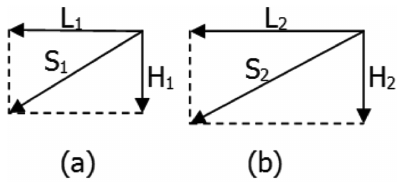
Figure 8: The displacements of A and B: a) A; b) B.